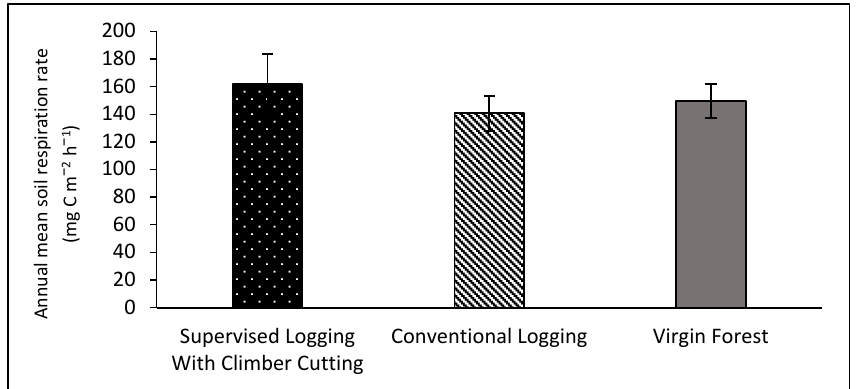
Figure 5. The annual soil respiration rate (mg C m − 2 h − 1 ) in supervised logging with climber cutting plots (SLCC), conventional logging plots (CL), and virgin forest plots (VF) at Gunung Rara Forest Reserve, Sabah, Malaysia. Error bars represent the standard error for the measurements.